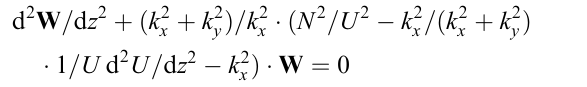
Fig. 6. Observations of mountain wave ac- tivity over Aberystwyth, Wales. Upper panel : hourly averages of velocity in the vertical antenna beam observed with the VHF radar. Lower panels : wind speed and direction at heights between 2.00 km and 2.75 km (from Prichard et al ., 1995,